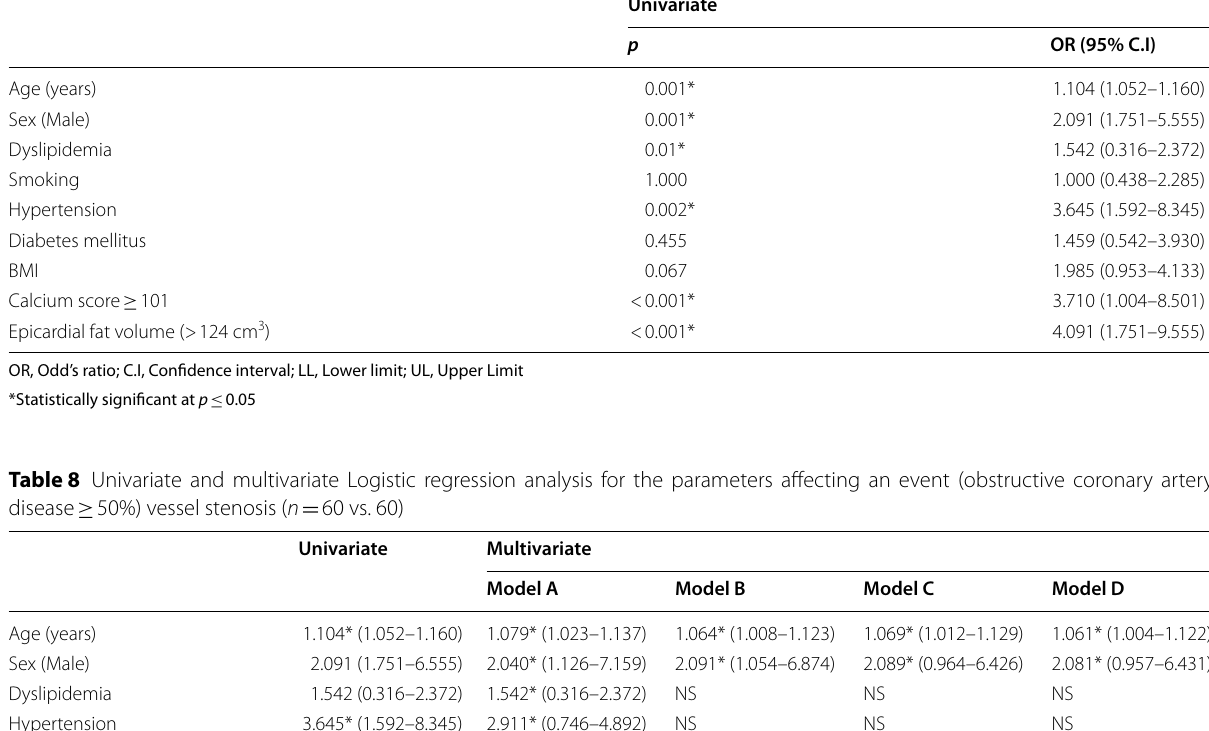
Table 7 Univariate Logistic regression analysis for the parameters affecting an event (obstructive coronary artery disease vessel stenosis ( n 60 vs.60) =